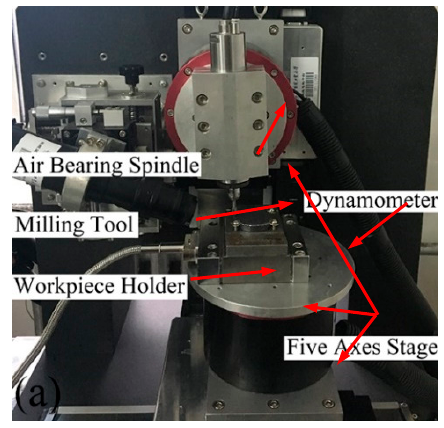
Figure 1. The experimental set-up for milling monocrystalline silicon. Table 1. The machining conditions for the milling operations and responses: measured surface finish, cutting force mode, and milling mode.